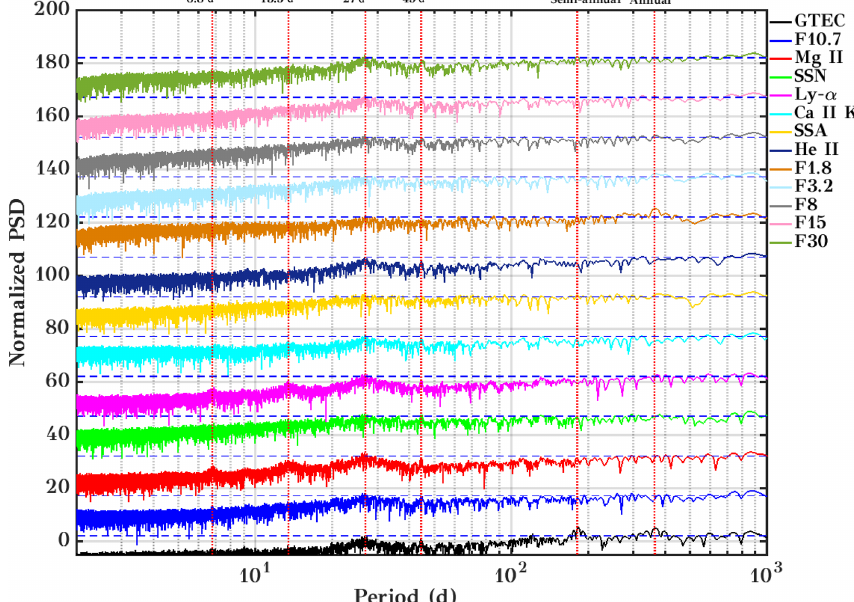
Figure 4. Lomb–Scargle periodogram for GTEC and multiple solar proxies with a 95% confidence line (dashed blue color line). The curves are vertically offset by a factor of 15